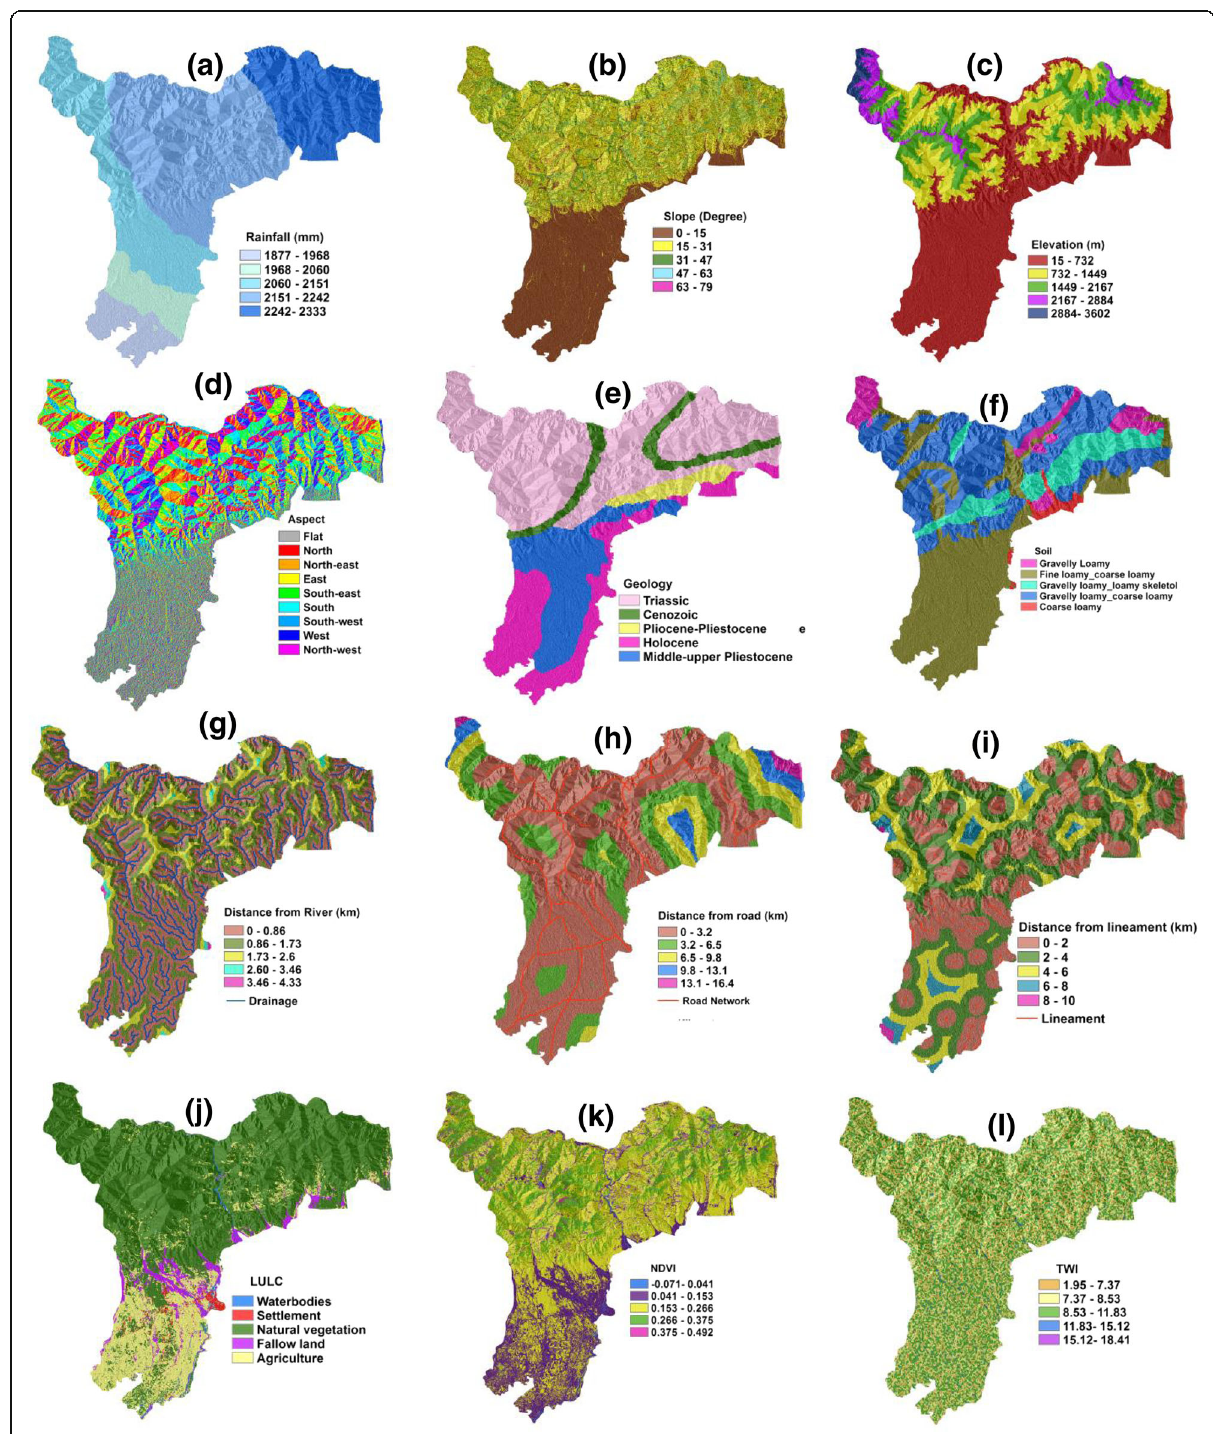
Fig. 3 Landslide conditioning factor maps used in this study: a Rainfall, b Slope, c Slope Elevation, d Aspect, e Geology, f Soil Map, g Distance from River, h Distance from Lineament, i Distance from Road, j Land Use/ Land Cover, k NDVI, l